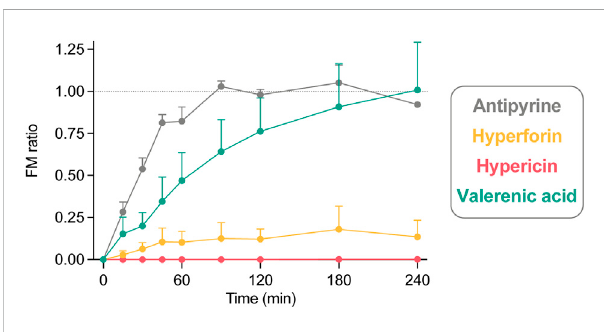
FIGURE 3 The fetal-maternal concentration ratio (FM ratio; fetal concentration divided by maternal concentration) calculated for each timepointofhyperforin(n=4),hypericin(n=3),andvalerenicacid(n= 4), in comparison with antipyrine (n = 3) from control perfusions. The FM ratio is 1.0 when the fetal and maternal concentrations are equal. All data are expressed as mean ±